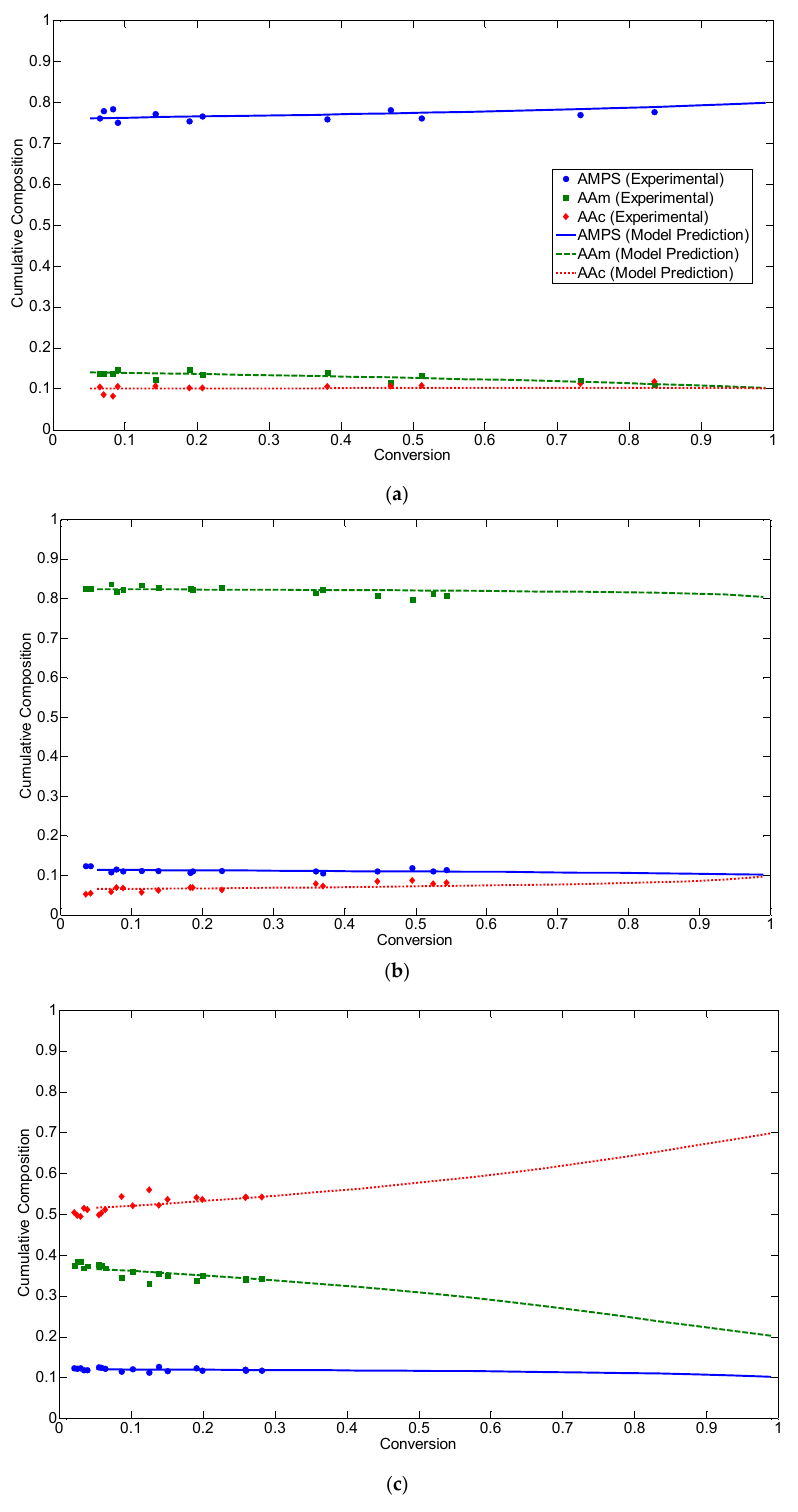
Figure 4. Cumulative terpolymer composition, F i , for AMPS/AAm/AAc (experimental data and model predictions) for f AMPS,0 / f AAm,0 / f AAc,0 = ( a ) 0.8/0.1/0.1, ( b ) 0.1/0.8/0.1 and ( c ) 0.1/0.2/0.7.